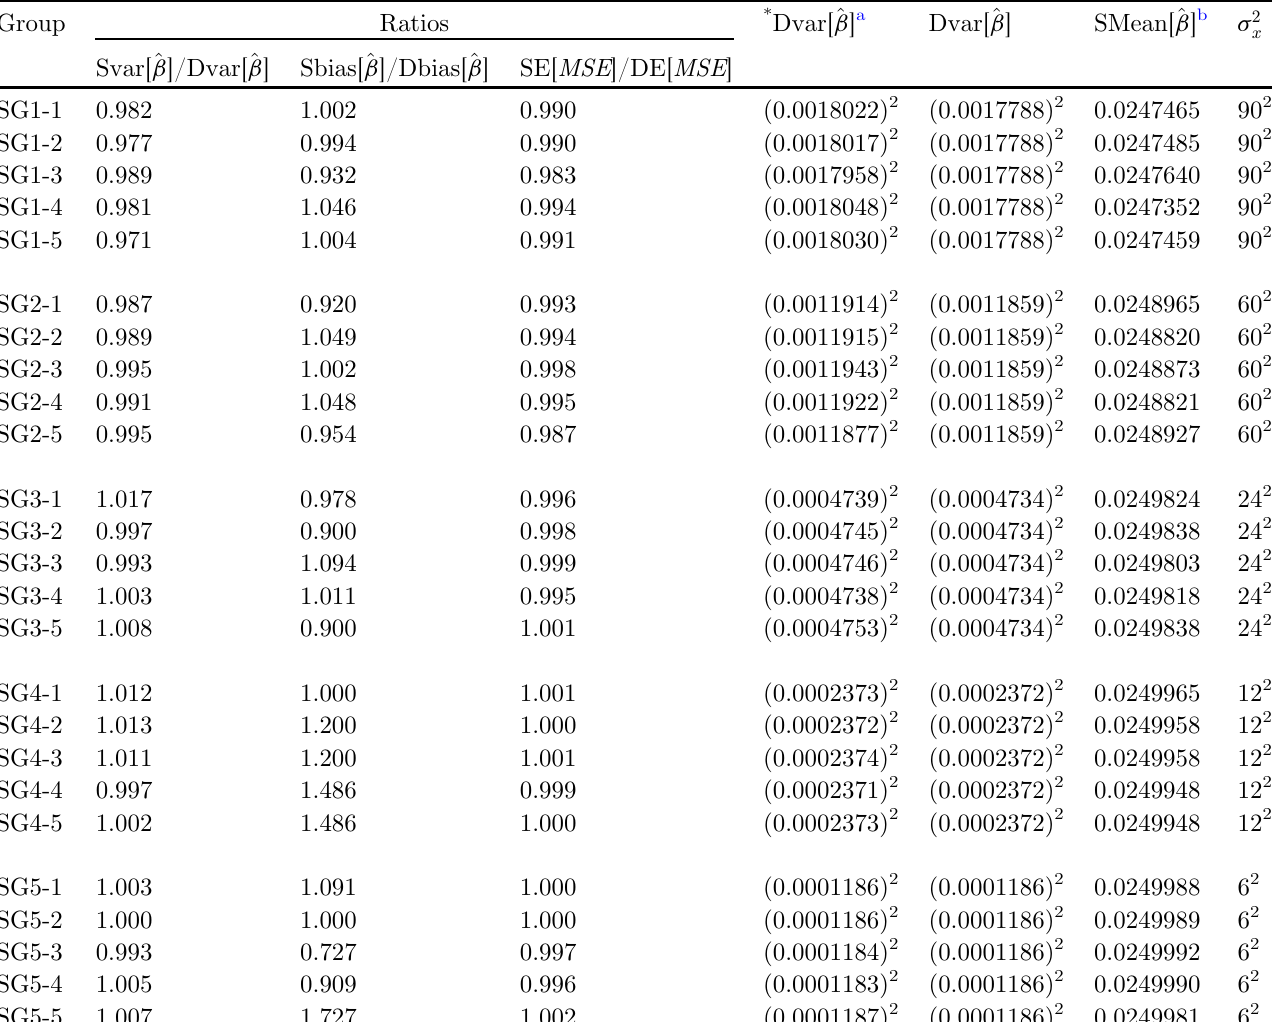
Table 2. Ratios of the simulation results to the corresponding derived properties. Group